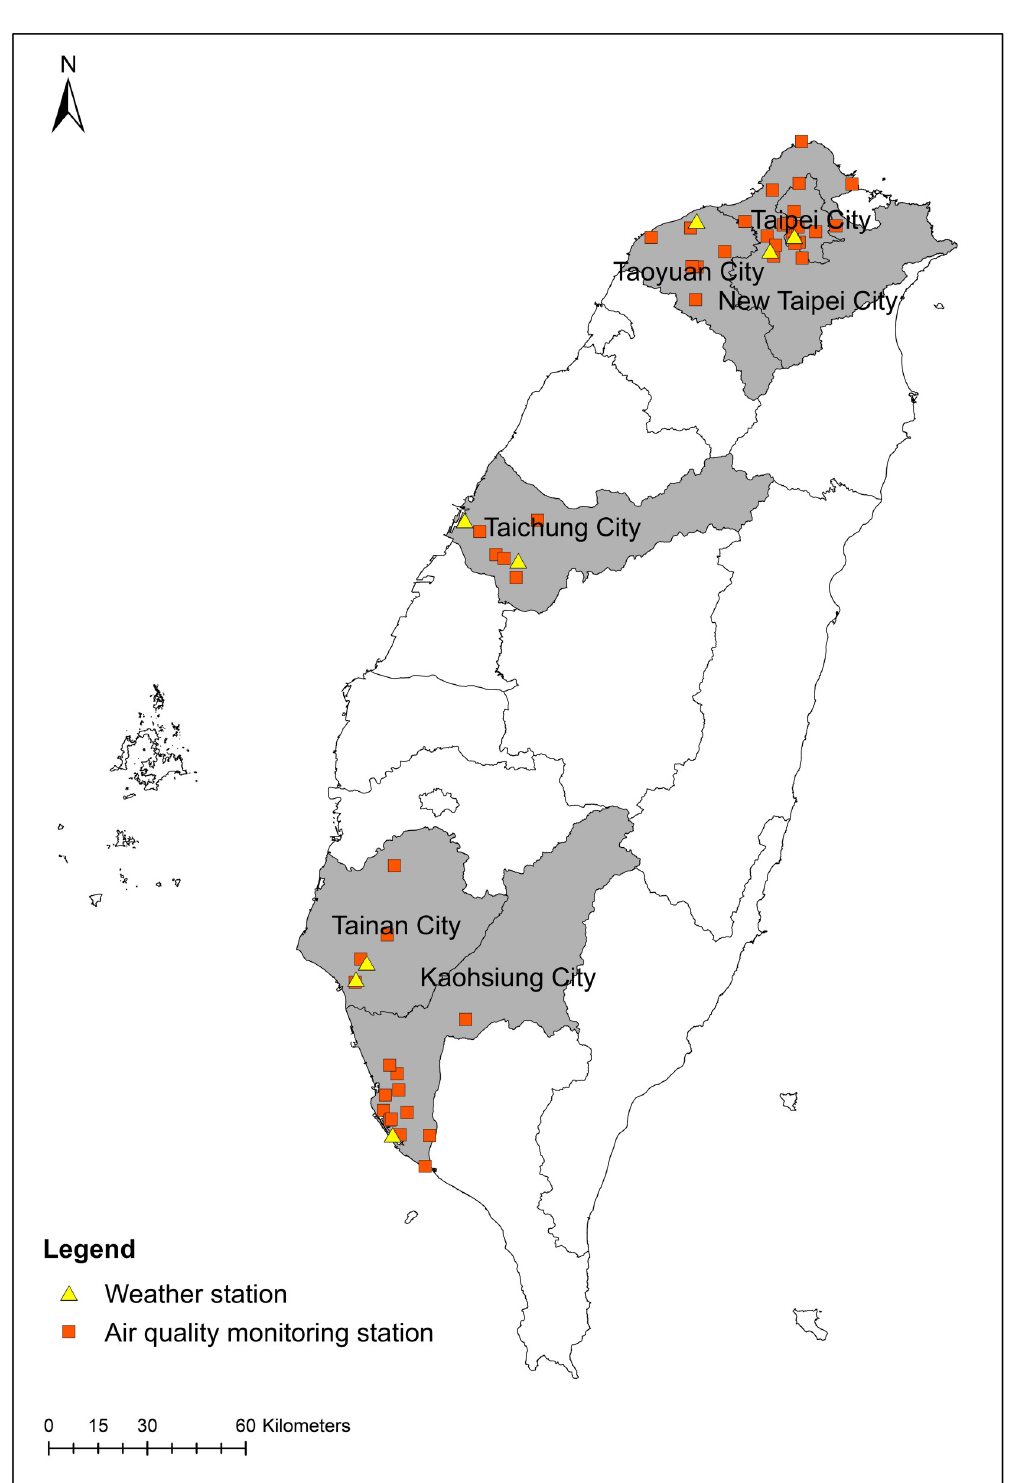
Fig 1. Locations of weather observatories and ambient air quality monitor stations in metropolitan cities in Taiwan.